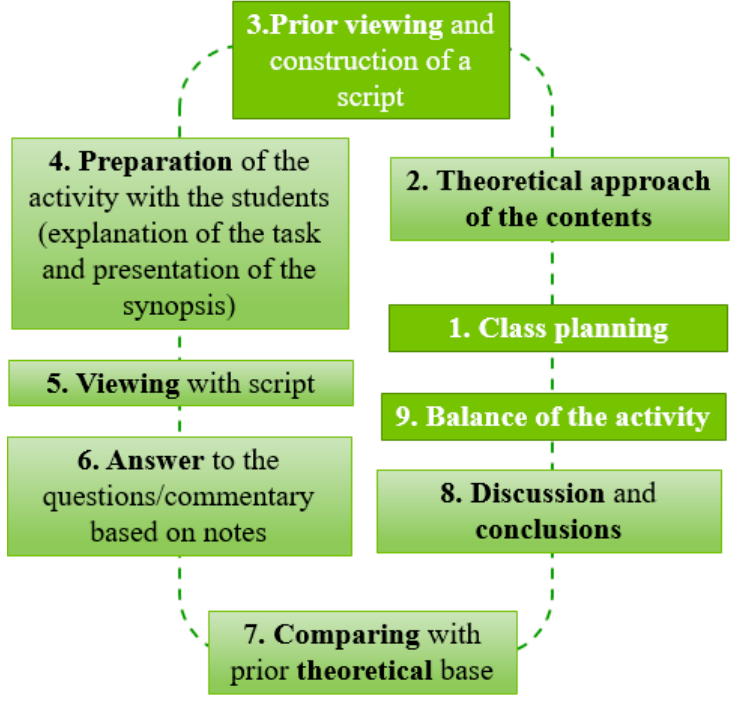
Figure 2. Proposal of class planning sequence: film analysis (Self-made,